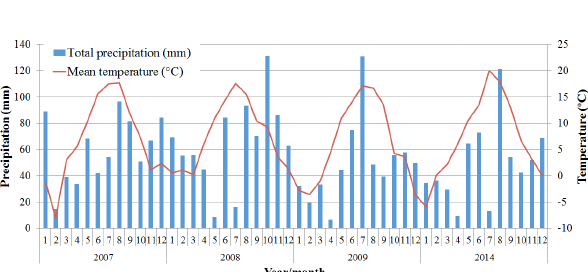
Figure 2. Monthly mean temperature ( ◦ C) and total precipitation (mm) for four years, measured at the meteorological station of